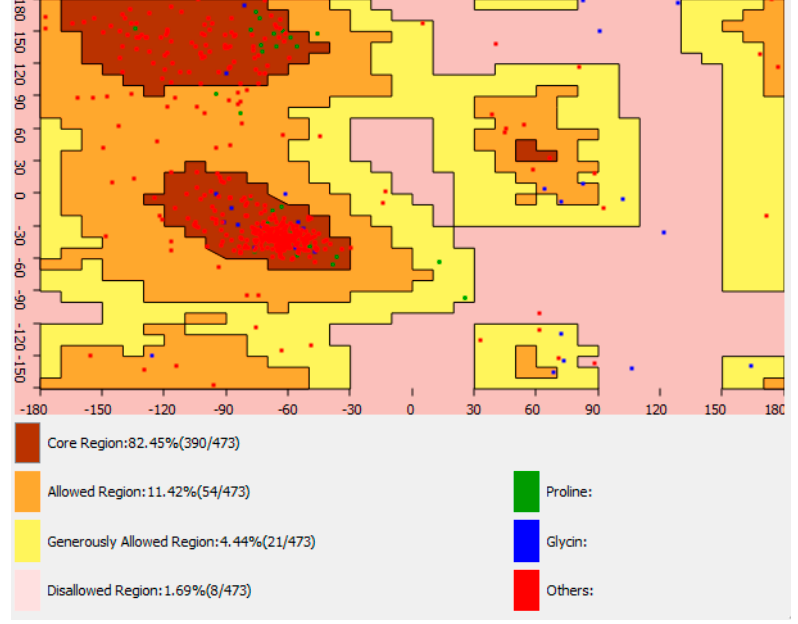
Figure 2. Ramachandran Plot for structural validation.